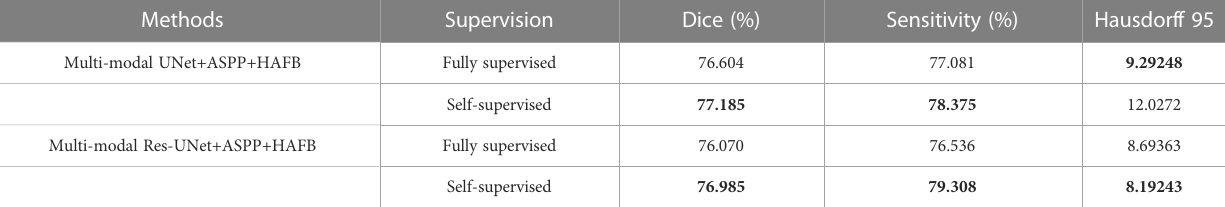
TABLE 3 Ablation experiment results on BraTS 2019.